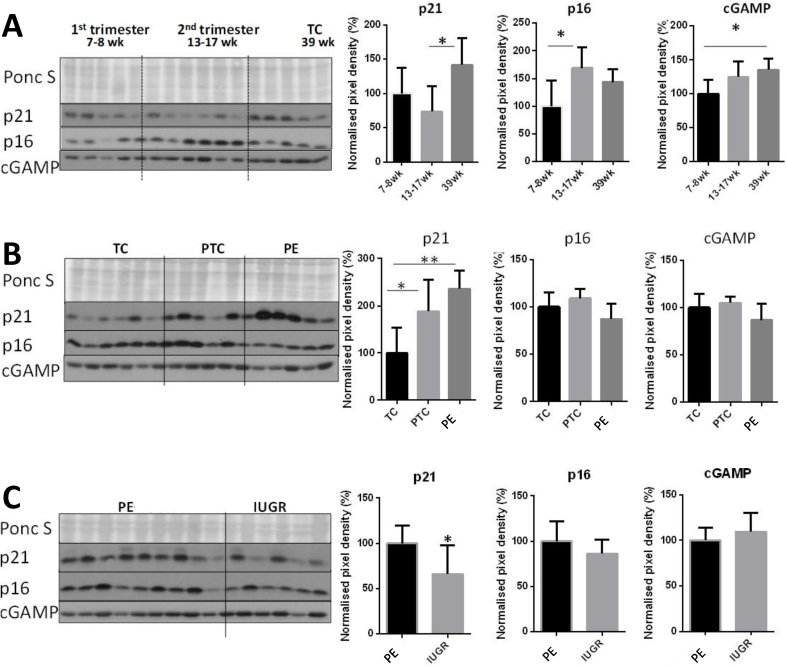
Evidence of senescence across gestation in first, second trimester and term samples collected by chorionic villus sampling technique (A: first trimester (7–8 wk; N = 5), second trimester (13–17 wk; N = 6), term (TC; 39 wk; N = 5)), in pathological placentas (B: term (N = 6, 39 wk) and pre-term controls (N = 5, 29 wk), and early-onset PE (N = 6, 30 wk); C: early-onset PE (N = 9, 30 wk), and IUGR placentas (N = 6, 31.5 wk)) obtained from elective caesarean deliveries. Placental tissue homogenates were probed with anti-p21, anti-p16, or anti-cGAMP antibodies and the signal was quantified. A) Quantification of Western blots revealed significant increase in p21 protein in term placental homogenates compared to first and second trimester samples, while p16 increased significantly in the second trimester but showed no further difference at term. B) The p21 and p16 expression was compared in term and preterm control placentas with samples from early-onset PE (PE). Levels of p21 were lowest in term control placentas, and significantly higher in both preterm controls and PE. There were no significant differences in p16 protein among the three groups. C) Levels of p21 were significantly higher in placentas from PE, and again there was no significant difference in p16. Data are presented as mean ± SD. *p < 0.05. Comparisons were made using ANOVA with a Tukey's multiple comparison post-hoc test in A and B, or using a two-tailed Student's t-test where only two groups of samples were compared (C).